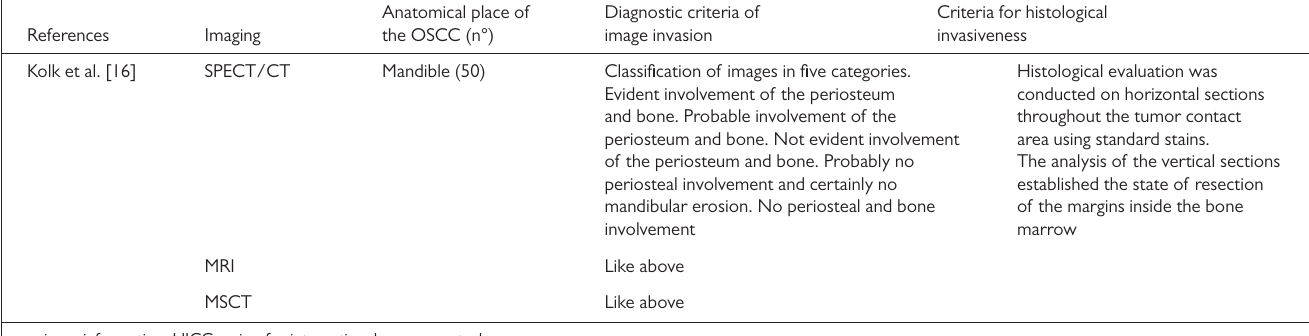
Table 4. Sensitivity, specificity, and diagnostic accuracy values for each study